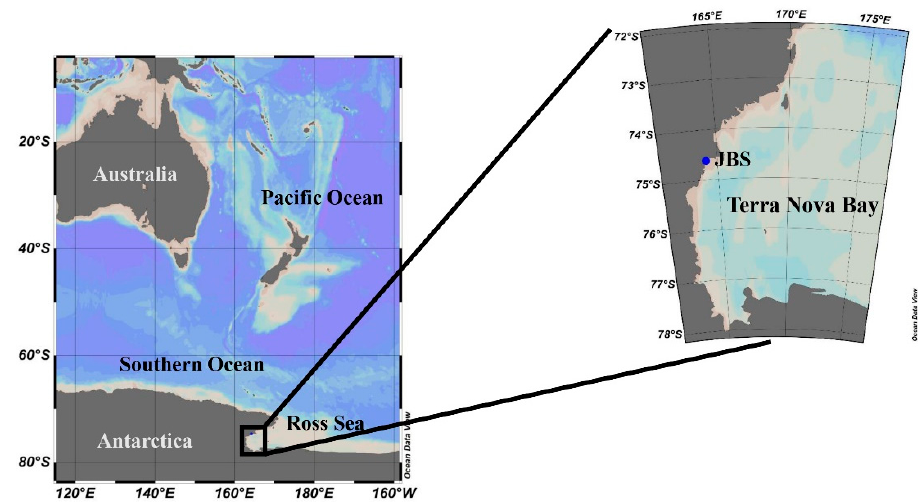
Figure 1. Location of the Jang Bogo Station (JBS) in Terra Nova Bay, Ross Sea.